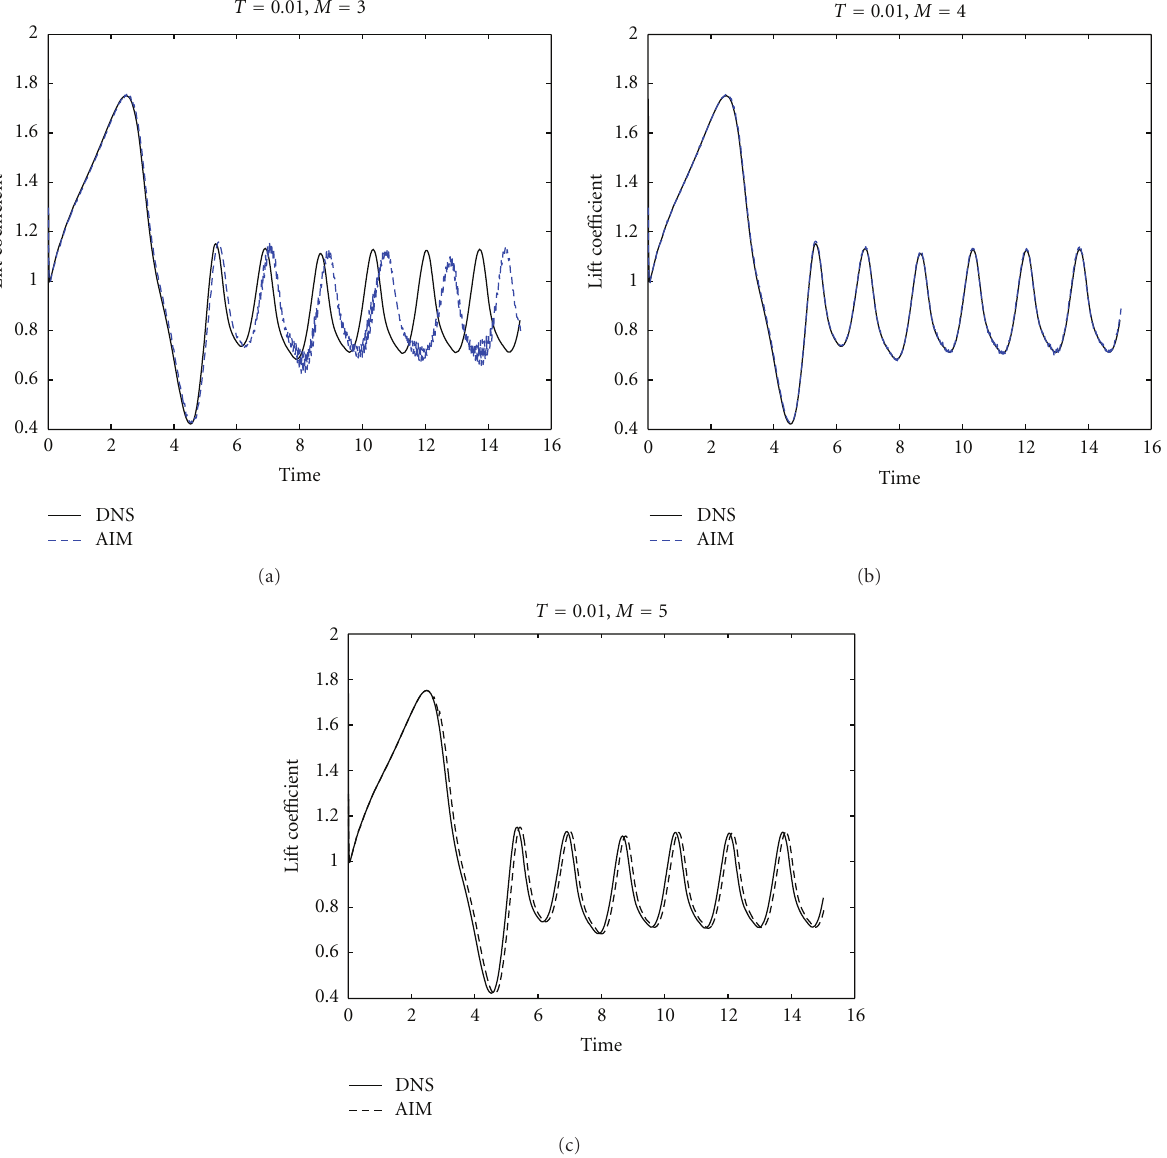
Figure 7: Transient Dynamics: Re = 800, lift coe ffi cient for T = 0 . 01 with various number of M . From top to bottom: M = 3,4, and